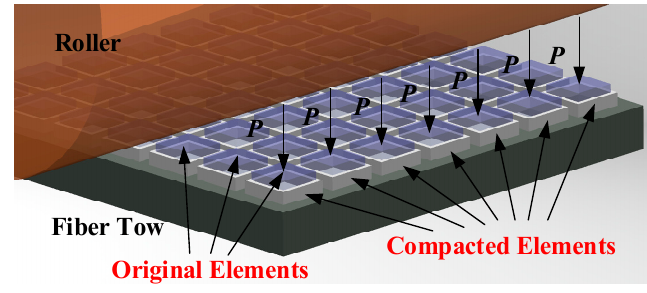
Figure 3. Diagram of intimate contact.